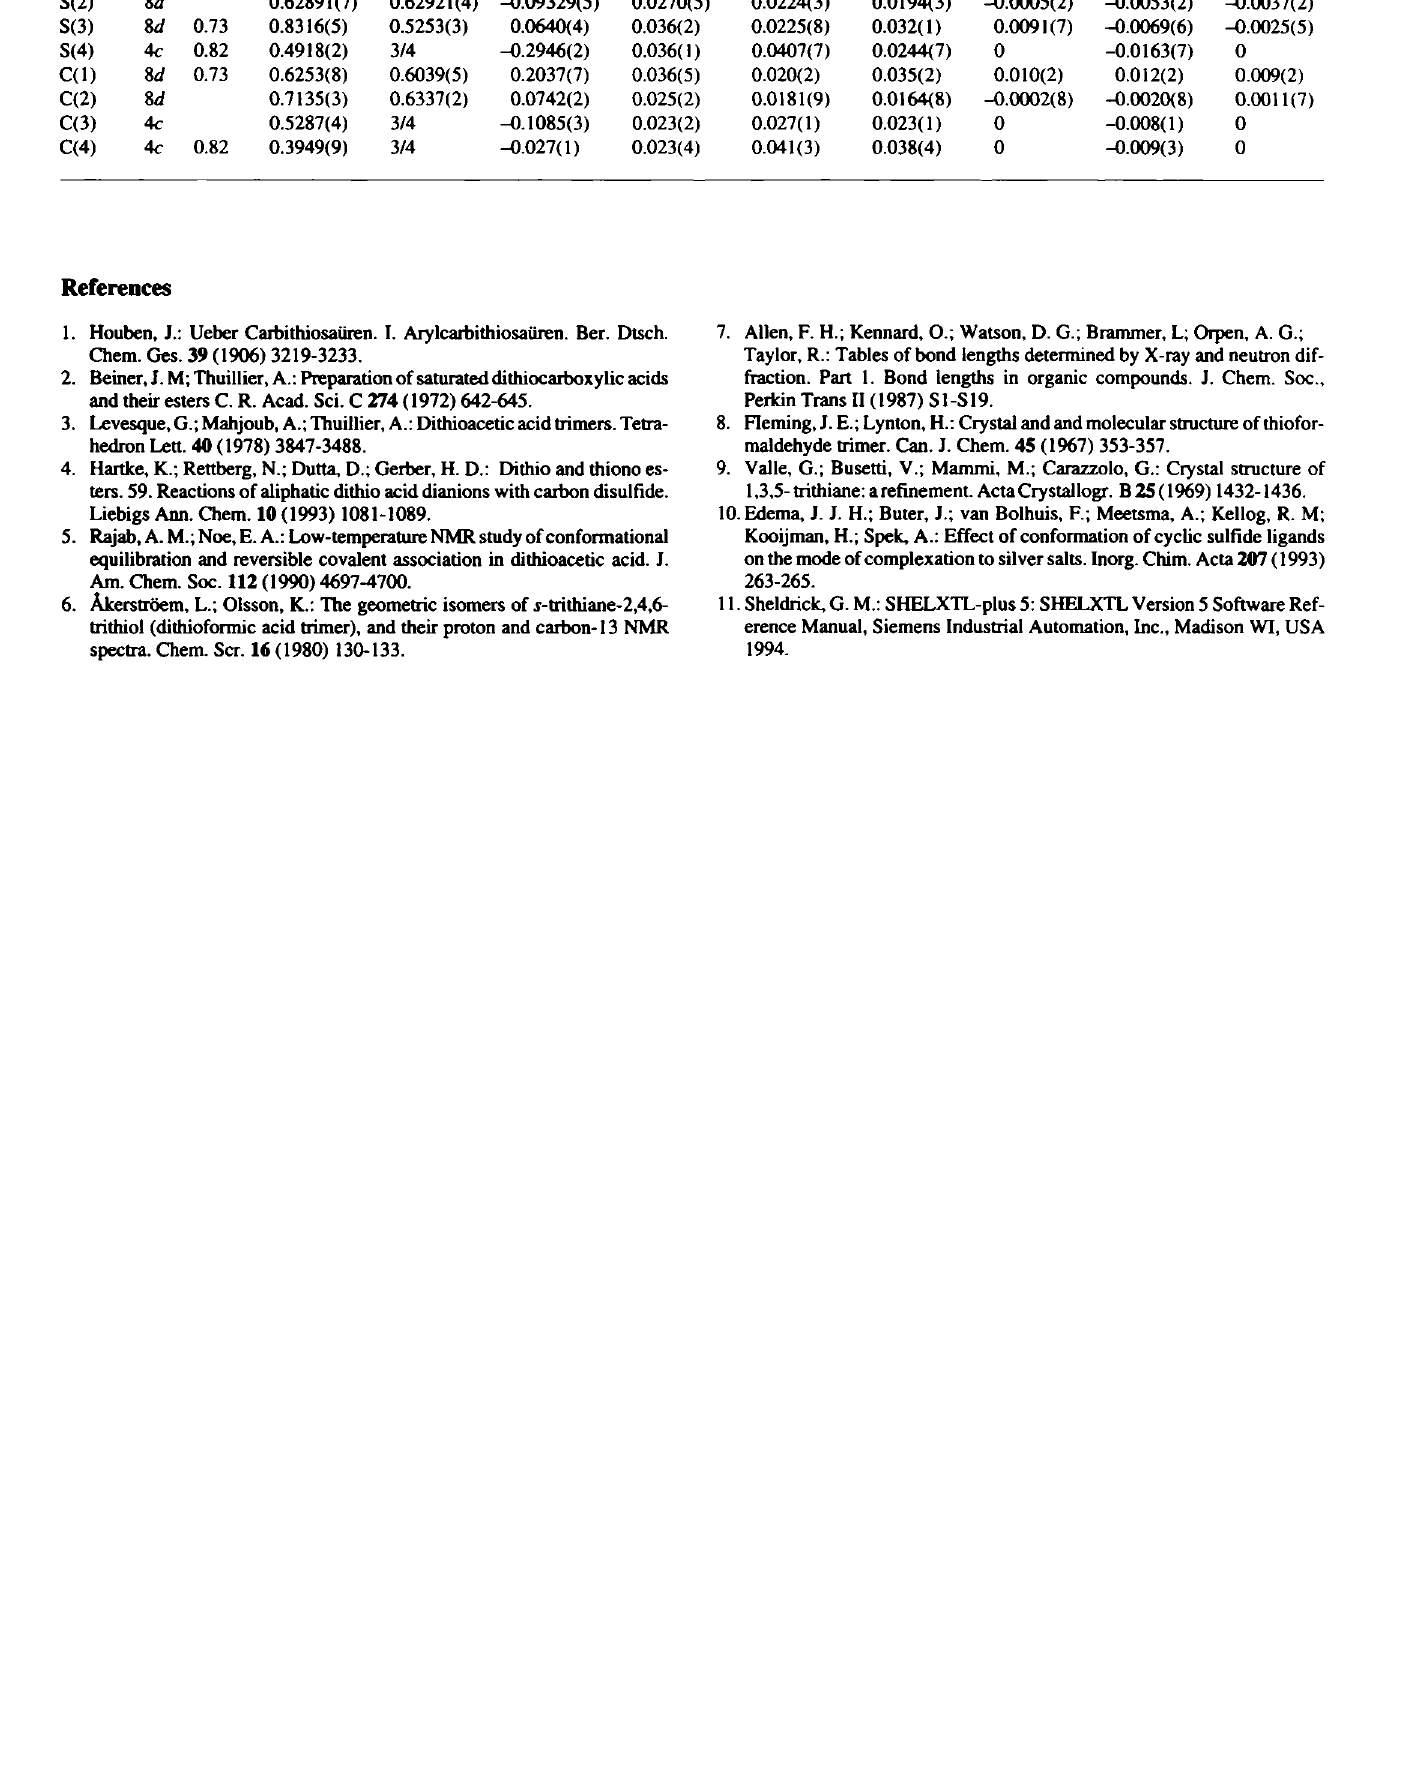
Table 3. Atomic coordinates and displacement parameters (in À 2 ). Atom Site